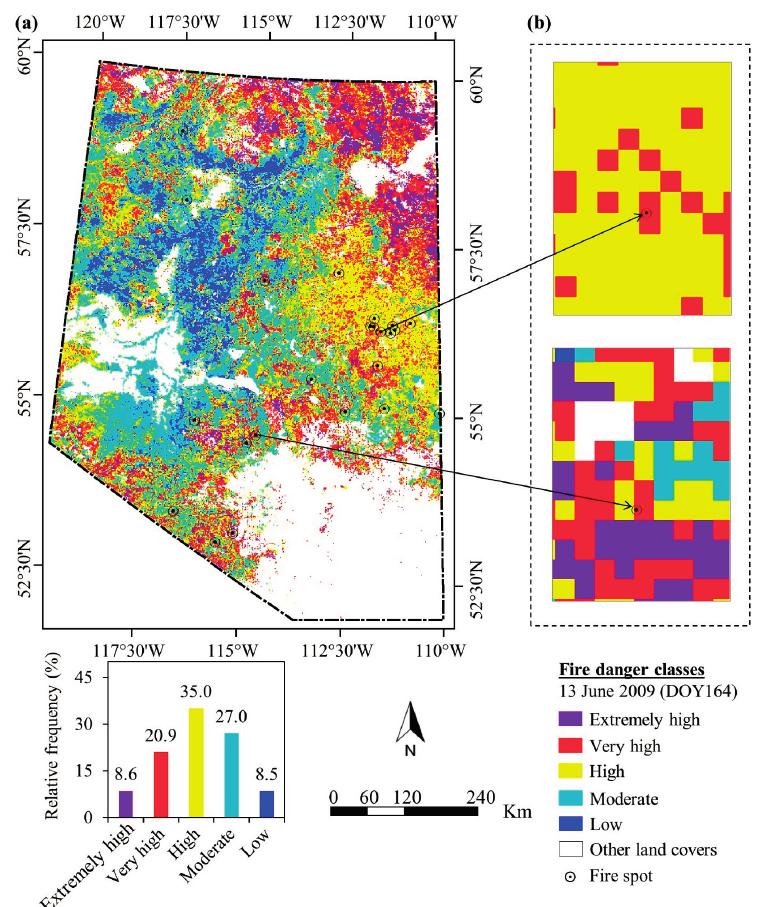
Figure 5. ( a ) Fire danger map for 13 June 2009, forecasted by combining the T S , NMDI, NDVI, and PW variables exploited during the immediate preceding day i.e. , 12 June